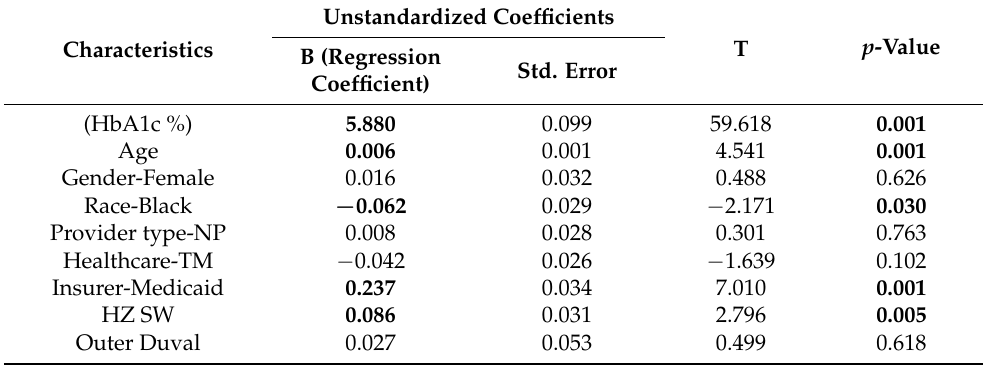
Table 3. Multiple Linear Regression Analyzing HbA1c % Levels and